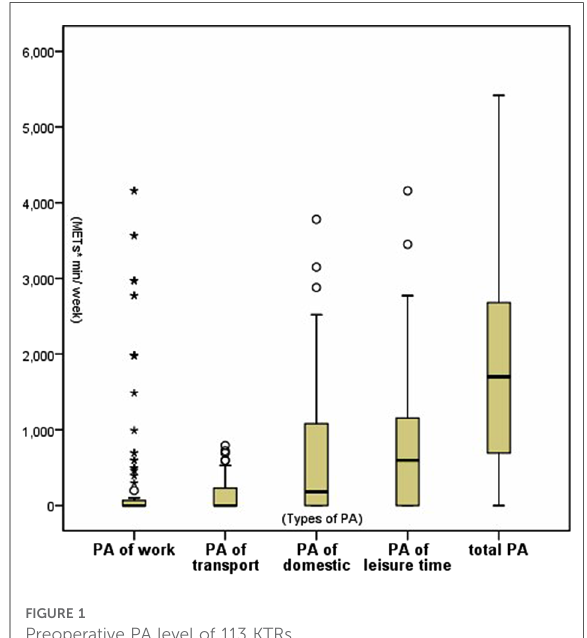
FIGURE 1 Preoperative PA level of 113 KTRs.